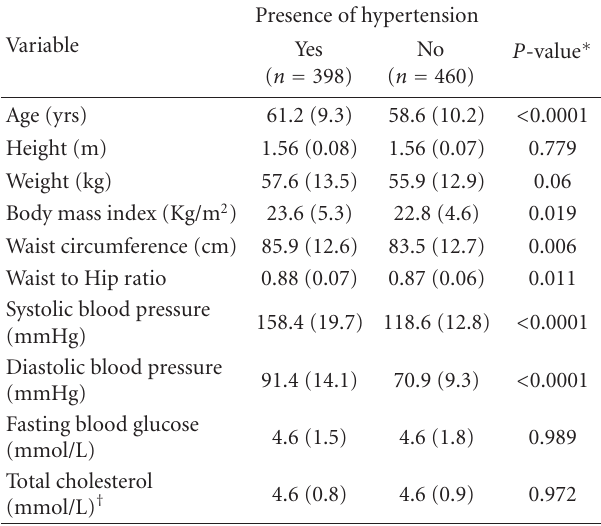
Table 1: Clinical Characteristics of all the subjects by their hyper- tensive status.